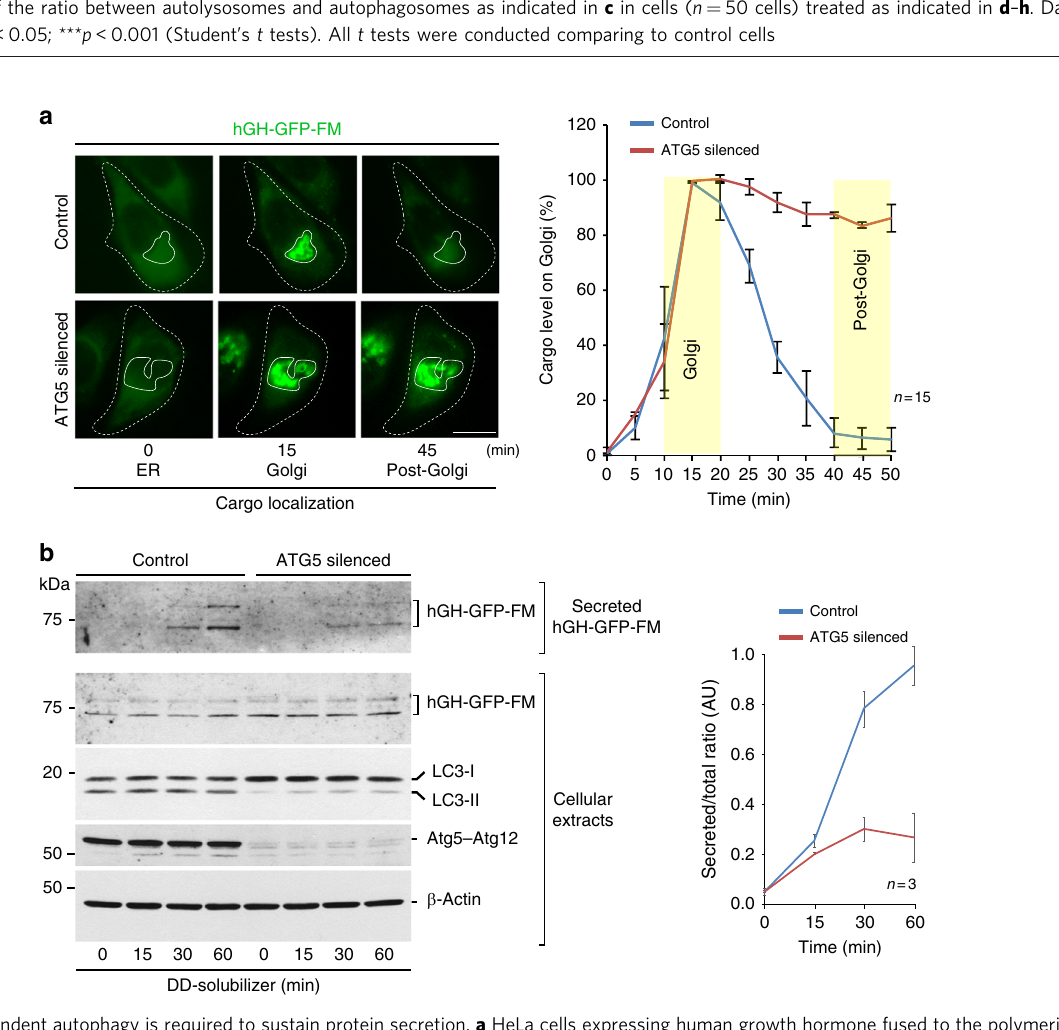
Fig. 6 ATG5-dependent autophagy is required to sustain protein secretion. a HeLa cells expressing human growth hormone fused to the polymerization/ depolymerization FM domain (hGH-GFP-FM) were subjected to control silencing (Control) or ATG5 silencing and further subjected to the endoplasmic reticulum (ER)-to-Golgi cargo transport assay. Cargo traf fi cking was tracked by time-lapse fl uorescence microscopy. Representative images show hGH- GFP-FM localization in the ER, Golgi or post-Golgi at the indicated times after addition of DD-solubilizer ( n = 15 cells). Scale bar, 10 µ m. The graph depicts the quanti fi cation of the level of cargo at the Golgi complex during the time of cargo traf fi cking from images as those shown in a , highlighting in yellow the timeframe of typical cargo localization in the Golgi complex or post-Golgi b . HeLa cells expressing hGH-GFP-FM were subjected to the same treatments shown in a , and the medium (Secreted) and cellular extracts were collected at the indicated times after addition of DD-solubilizer. Proteins from the medium and cellular extracts were analysed by sodium dodecyl sulphate-polyacrylamide gel electrophoresis (SDS-PAGE) and western blotting using antibodies to the proteins indicated on the right. The graph depicts the quanti fi cation of the ratio between secreted and total hGH-GFP-FM detected by western blotting ( n = 3 independent experiments). Data are means± SEM. GFP green fl uorescent protein